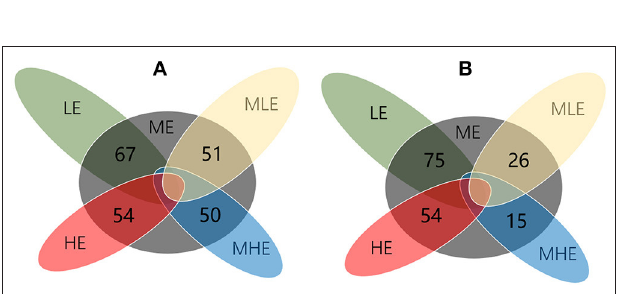
FIGURE 5 | The Venn diagram for illustrating the number of differential metabolites among groups. (A) Positive mode. (B) Negative mode.